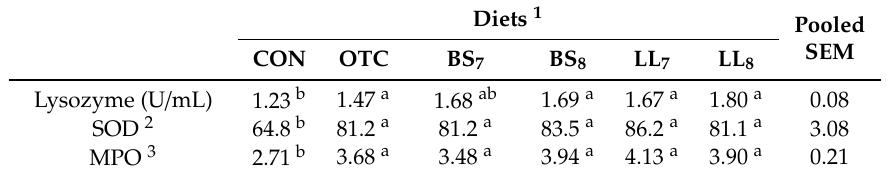
Table 5. Non-specific immune responses of juvenile Nile tilapia fed the experimental diets for 8 weeks.